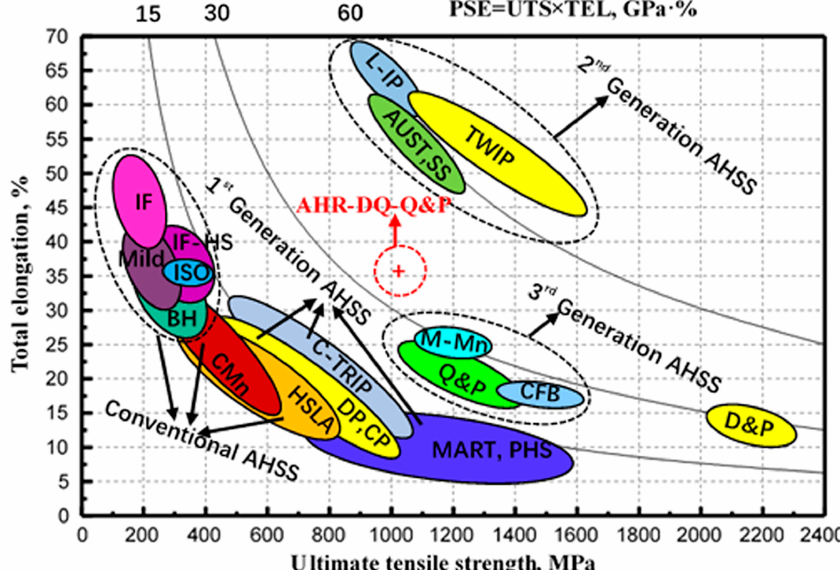
Figure 4. Summary of mechanical performance of those existing advanced high strength steels (AHSS) reported in the literature as compared to the investigated steel.